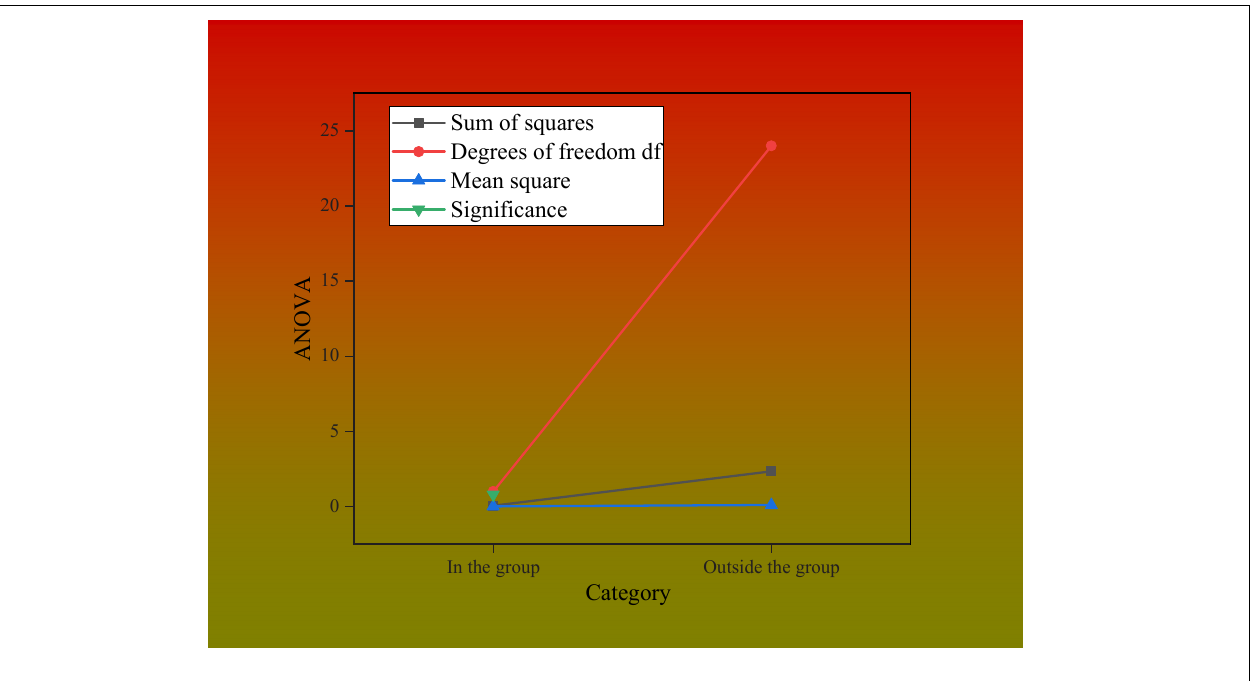
FIGURE 6 | One-way analysis of variance.